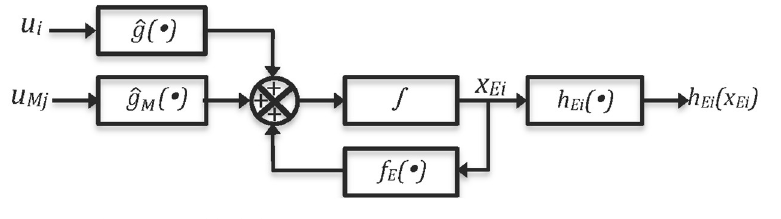
Fig 2. Auxiliary system block